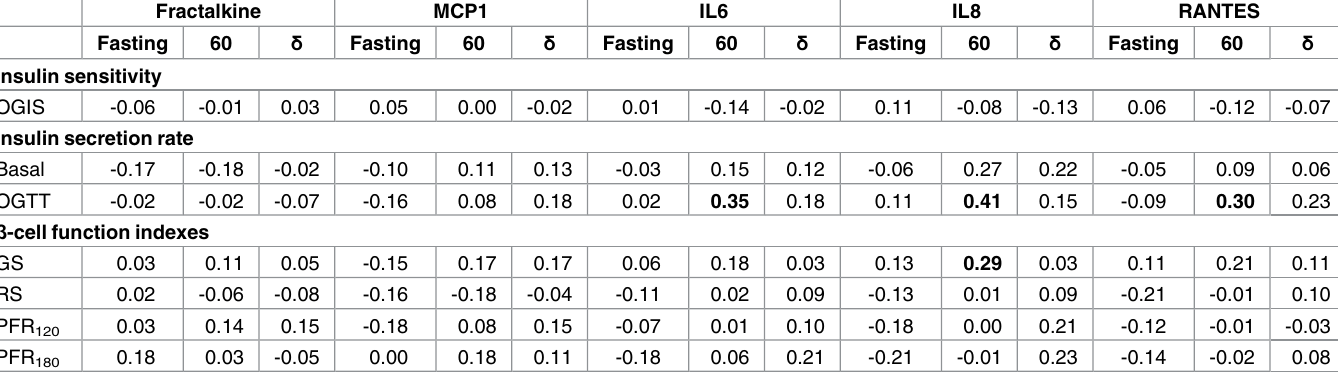
Table 3. Spearman correlation matrix of circulating chemokines concentrations with insulin sensitivity and β -cell function after the first 75-g oral glucose load.